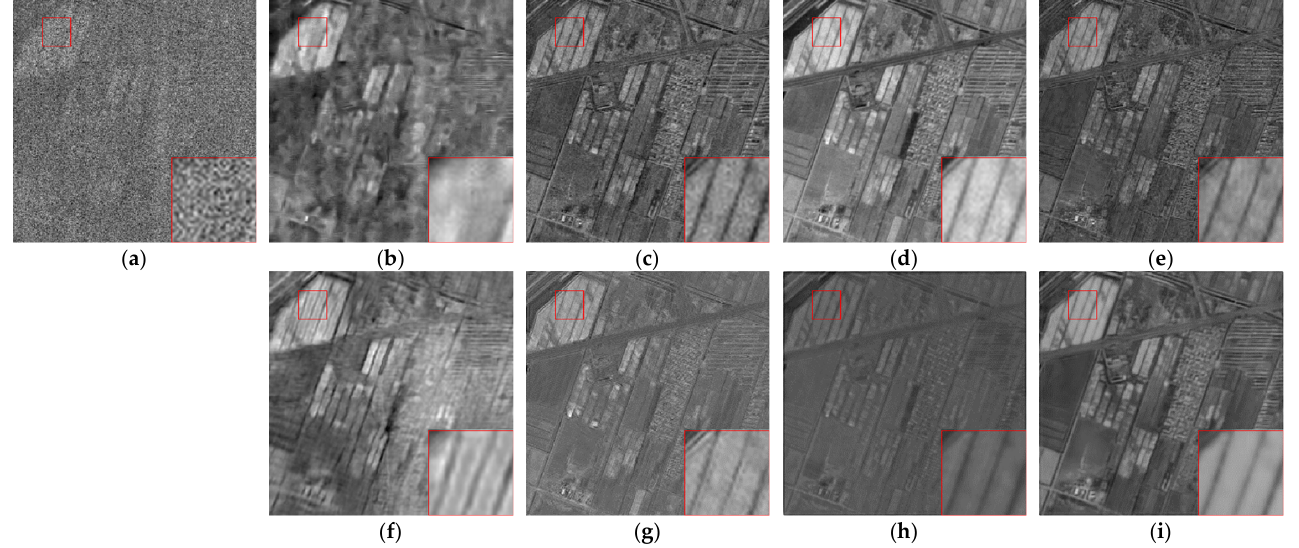
Figure 13. GF-14 hyperspectral image (VNIR) denoising results with band 5: ( a ) real image; ( b ) BM4D; ( c ) LRMR; ( d ) HyRes; ( e ) L1HyMixDe; ( f ) DHP-2D; ( g ) SIP; ( h ) SURE-CNN; and ( i ) 3S-HSID.